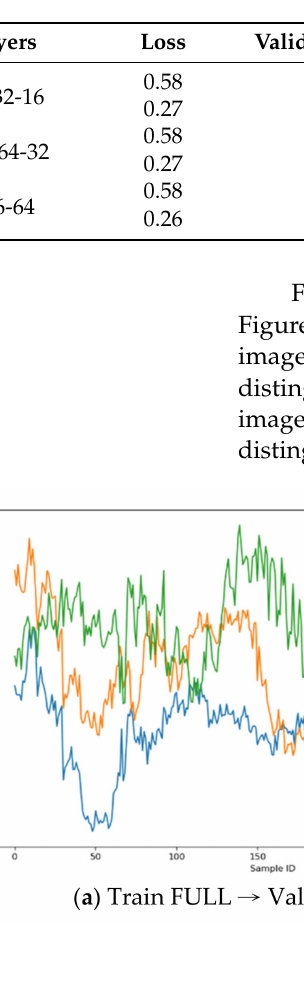
Table 4. MLP model performance against the standardized difference images.